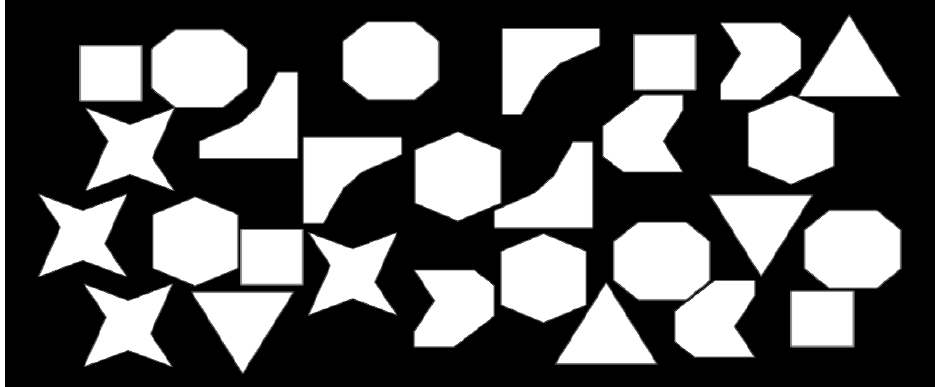
Figure 9. Solution found by the ILS algorithm using 28 pieces for the Shape 2 instance.